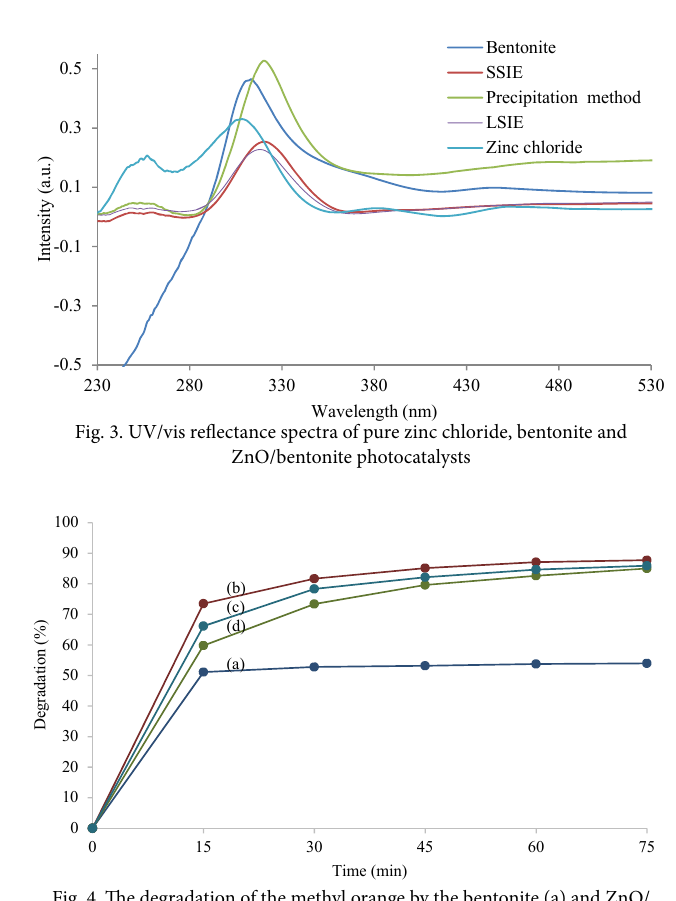
Fig. 4. The degradation of the methyl orange by the bentonite (a) and ZnO/ bentonite composites prepared by SSIE (b), LSIE (c) and precipitation method Figure 4. The degradation of the methyl orange by the bentonite (a) and ZnO/bentonite composites prepared by SSIE (b), LSIE (c) and precipitation method (d)